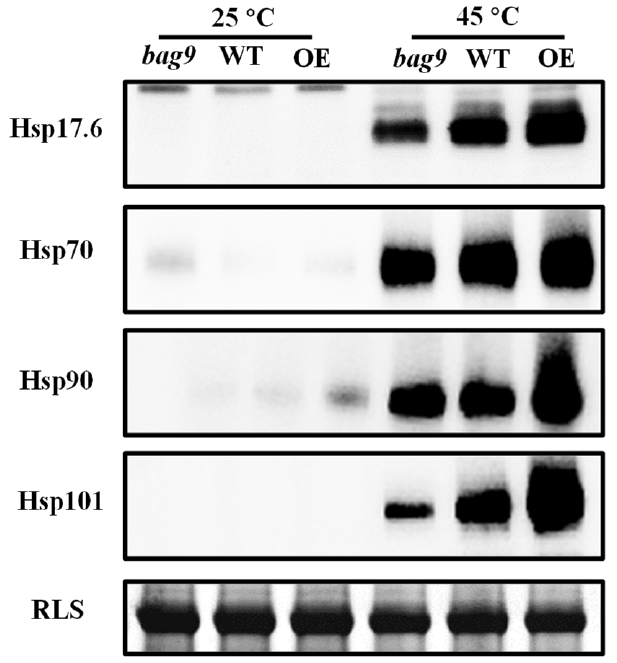
Figure 8. The accumulation of Hsps with or without heat stress in tomato leaves. Hsp17.6, Hsp70, Hsp90, and Hsp101 were detected by immunoblot analysis. After exposing to heat for 7 h, the leaf samples were obtained for experiments. The protein input was indicated by Coomassie Blue staining (CBB). Three independent experiments were performed with similar results. WT, wild type; BAG9 -OE, BAG9 overexpressing plants; RLS, Rubisco large subunit.